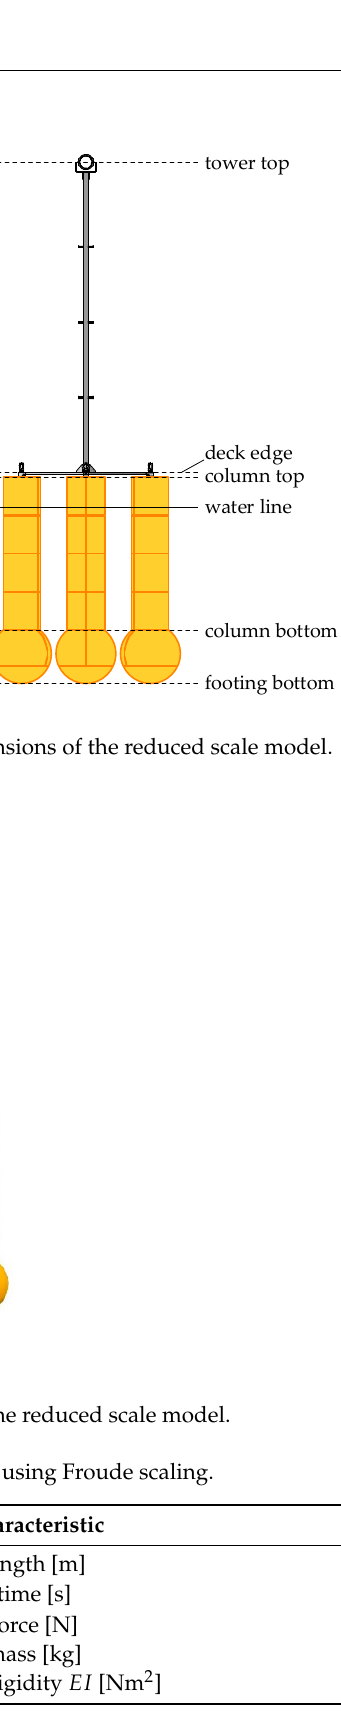
Figure 2. Main dimensions of the reduced scale model.